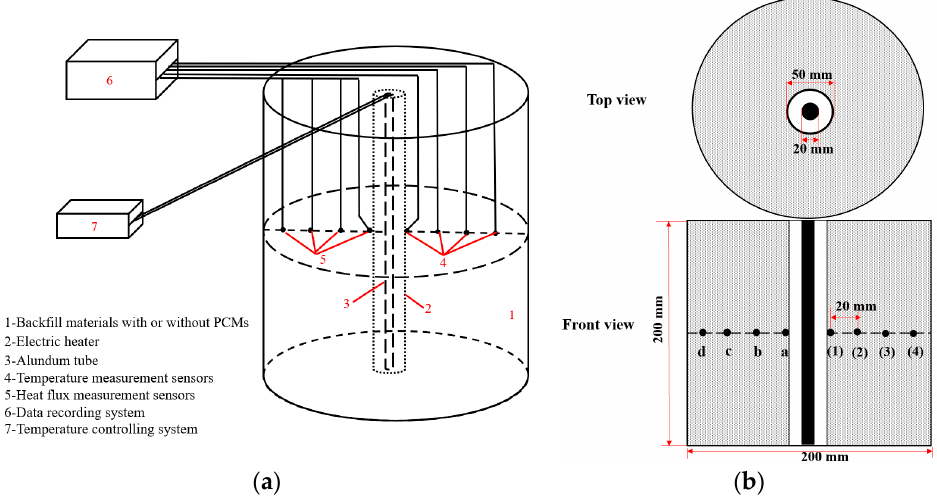
Figure 3. Self-designed setup: ( a ) Schematic; ( b ) Top view of the cylinder with